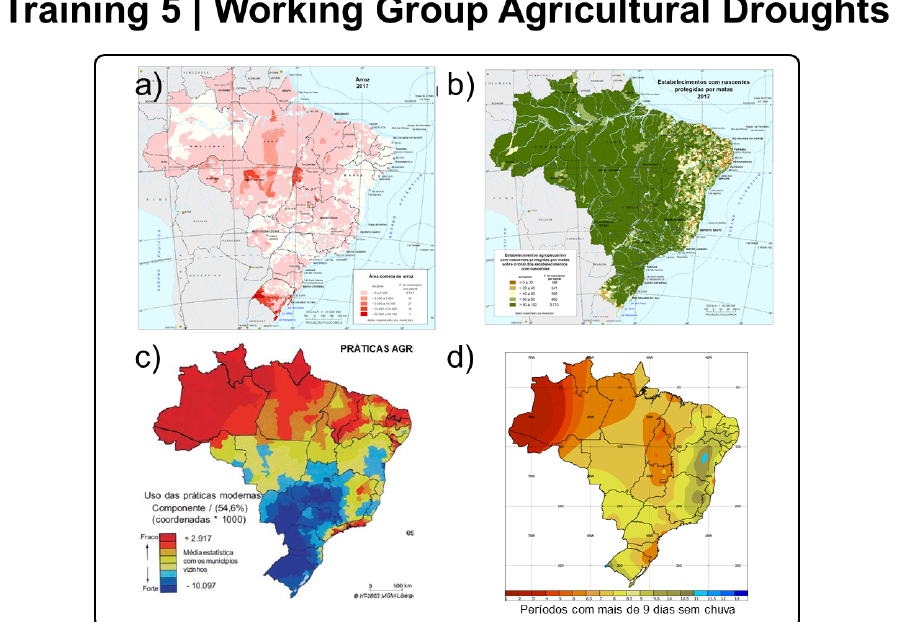
Figure A23. Package of maps used in the fifth training for mapping climate risk associated with agricultural droughts. The maps illustrate (a) rice production (IBGE, 2019), (b) properties with protected water springs (IBGE, 2019), (c) use of modern practices in agriculture (Théry and Mello, 2018), and (d) number of dry spells longer than 9d (Normais climatológicas do Brasil, 2020).